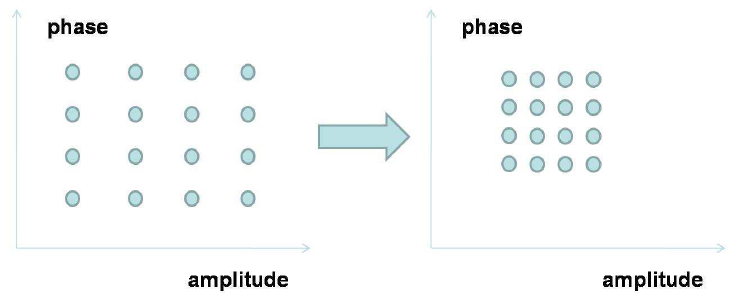
Figure 40. Illustration of parallel CUSUM test with successive refinement.